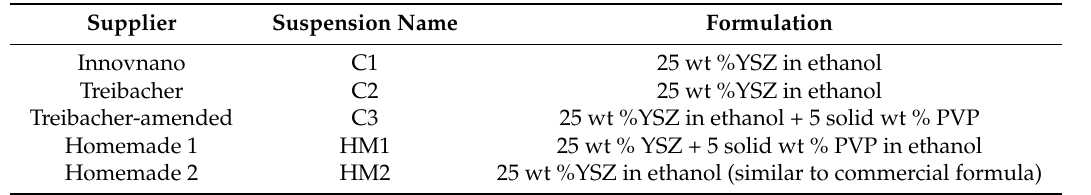
Table 1. Formulation of the investigated suspensions.